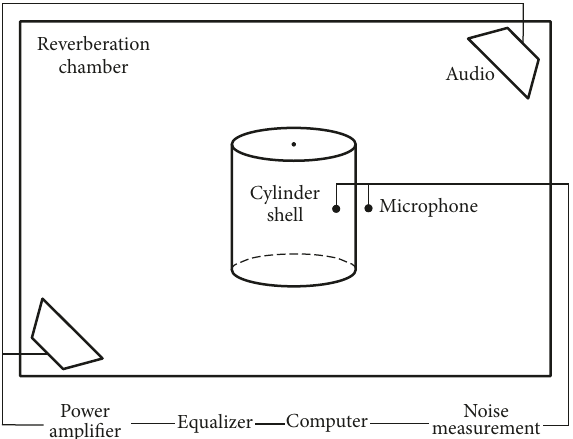
Figure 1: Sketch of the noise experiment.